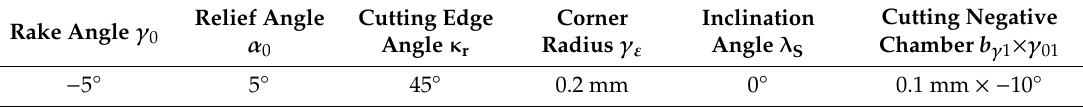
Table 3. Ceramic tool geometric parameters.